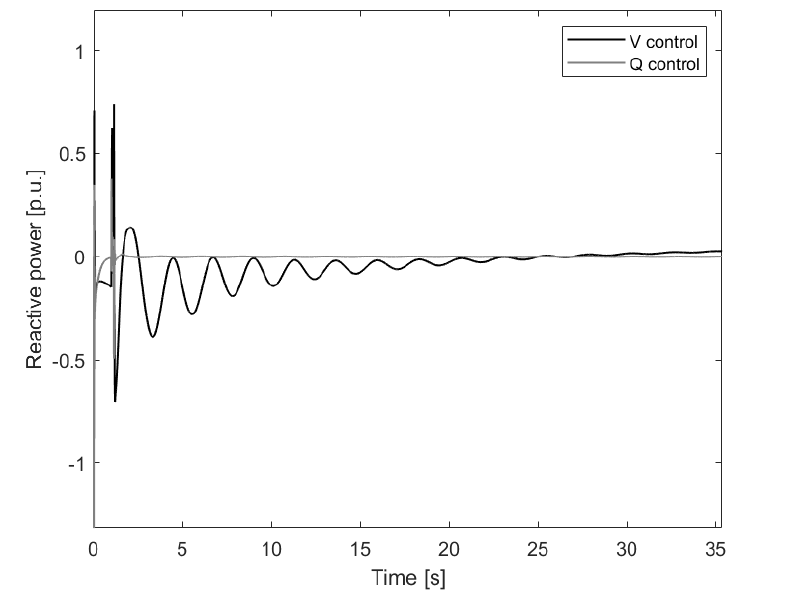
Figure 11. Reactive power provision from DFIGs in both V and Q control